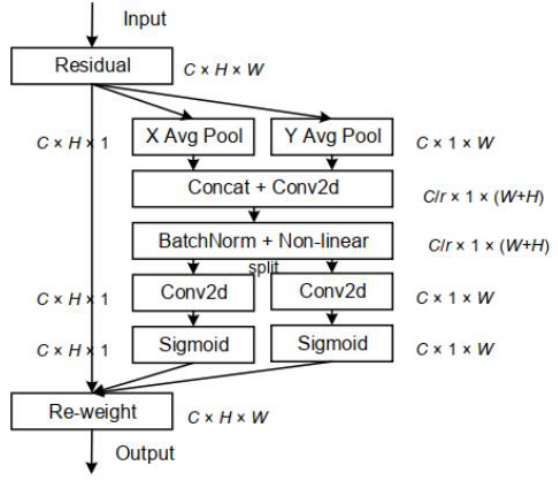
Figure 3. The structure of Coordinate Attention. C represents the number of channels; H represents the height; W represents the